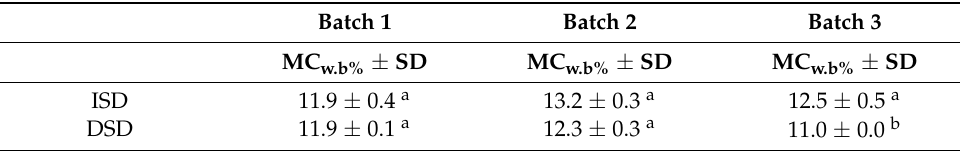
Figure 3. Moisture content (MC) ( a ) and moisture ratio (MR) ( b ) vs. time for drying maize in the inflatable solar dryer (ISD) and for direct sun drying (DSD) of three batches: B1, B2, and B3. Table 1. Moisture content (MC) before drying (fresh) and after drying in the inflatable solar dryer (ISD) and direct sun drying